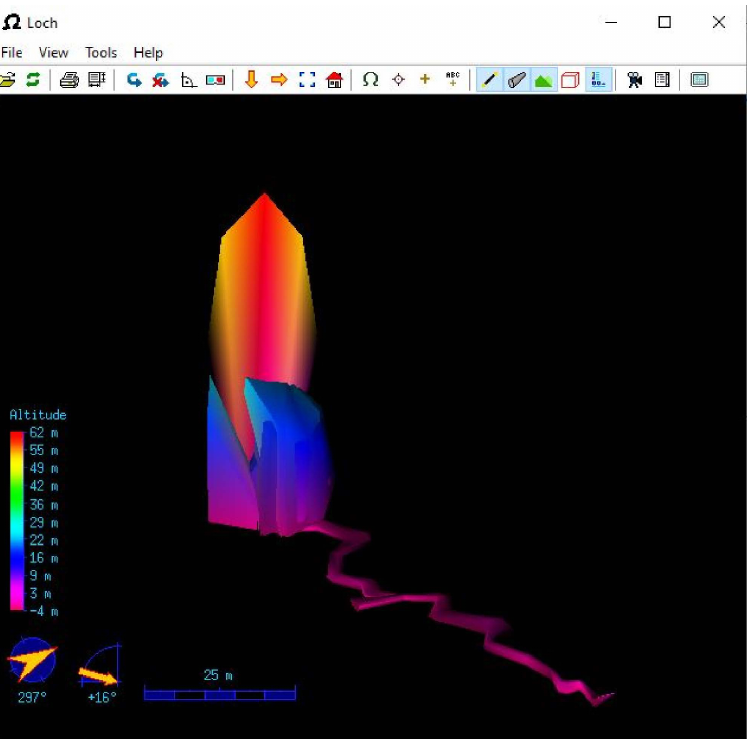
Figure 1. Example of a cave survey based on the laser range finder approach; the post-processing software adopted by cavers can be used for a coarse 3D reconstruction of the cave. The model presents the Gazzano cave that is the case study that is described and discussed in this manuscript.